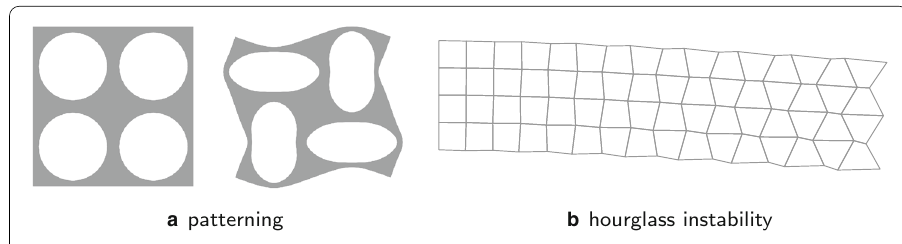
Fig. 1 a Typical patterning mode in mechanical metamaterial consisting of a square stacking of holes, cf. [5]. b Hourglassing observed in under-integrated elements in standard finite element